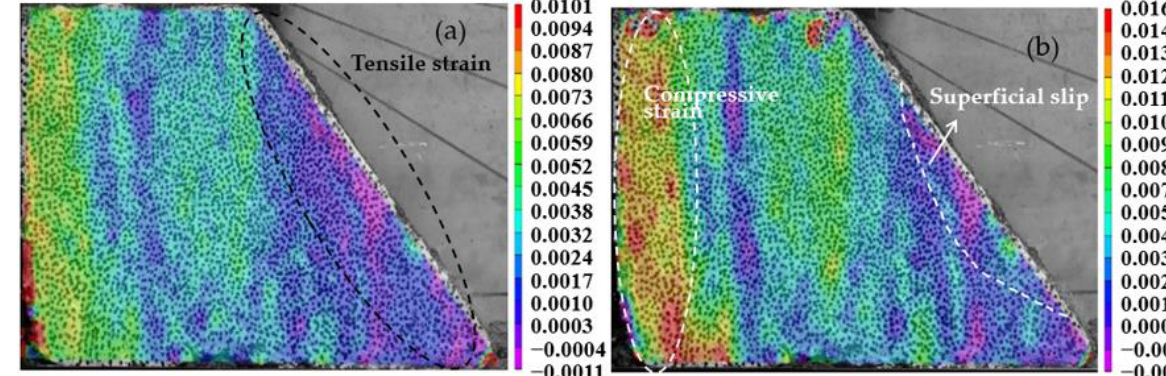
Figure 6. Strain contours of the slope model under different loadings and irrigation with 25 mL/min. ( a ) Under 1.6 MPa; ( b ) under 16 MPa.